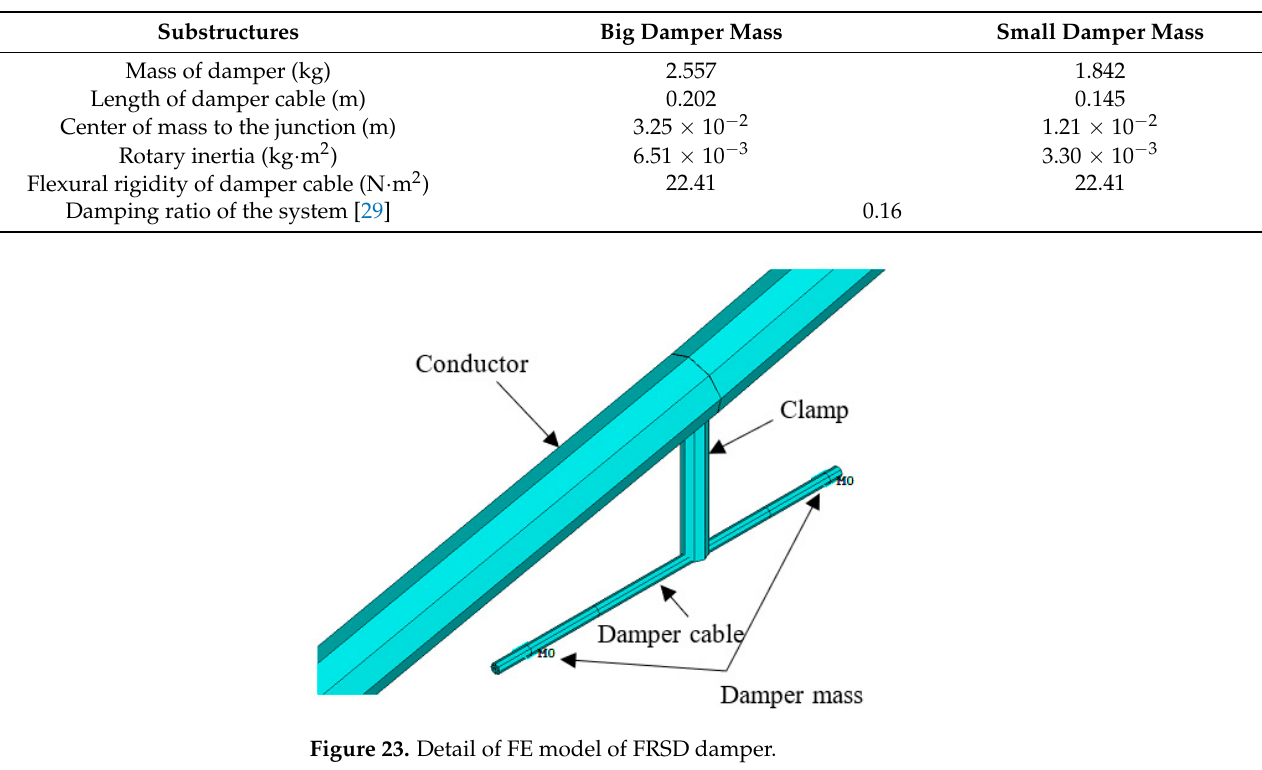
Table 2. Structure parameters of FRSD.